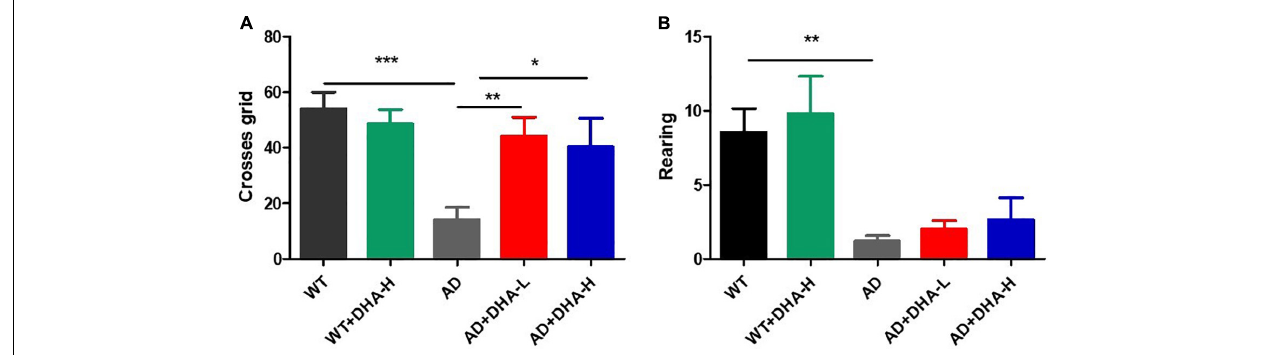
FIGURE 2 | Effect of DHA treatment for 4 months on depression- and anxiety-related behaviors in 2 × Tg AD mice. (A) Times of crossing grids; (B) times of standing (* p < 0.05; ** p < 0.01; *** p < 0.001). Student’s t test was used for statistical analysis. Error bars represent mean ± S.E.M. ( n =